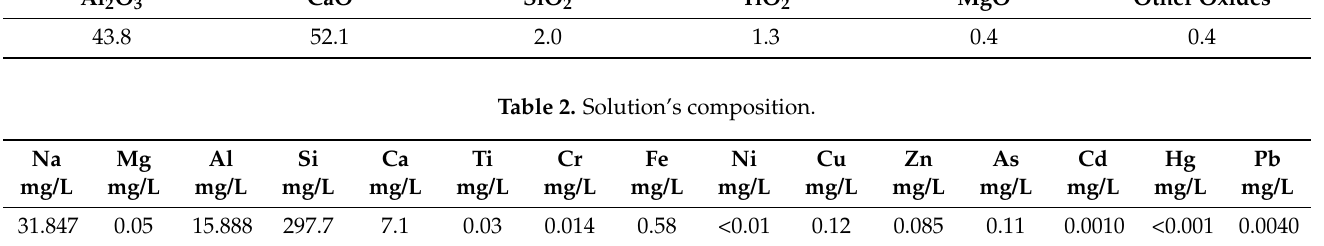
Table 1. XRF analysis of the leached slag (wt%).